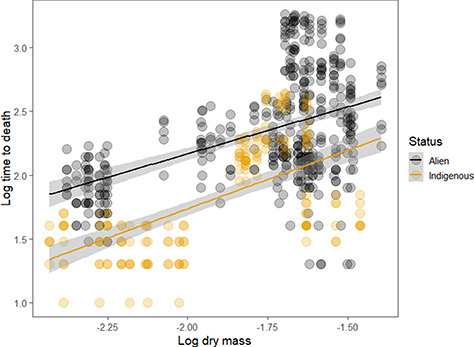
Relationship between time to death (log10, minutes) and dry body mass (log10, mg) for individuals of the F0 generation of springtail species from Macquarie Island subject to desiccation trials, indicating substantially greater desiccation resistance, on average, of the alien over the indigenous species. The fitted lines are from a linear model fitted in ggplot2